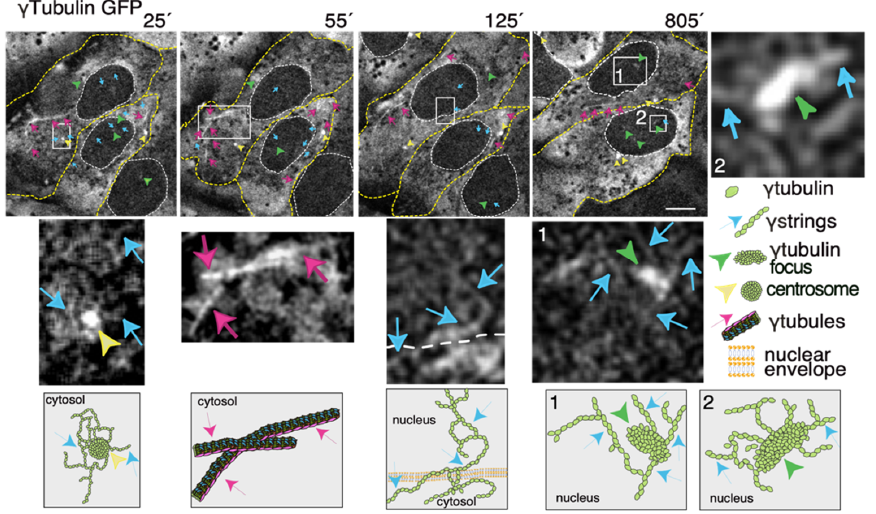
Figure 3. The dynamics of the γ -tubulin meshwork in living cells. Time-lapse series of fluorescence images showing U2OS cells stably coexpressing TUBG-short hairpin (sh)RNA and GFP-tagged sh-resistant γ -tubulin ( γ tubulin GFP). Images present chosen frames illustrating the changes in the position of γ -strings, γ -tubules, centrosomes, and γ -tubulin foci during the interphase. The outer membrane of the cells and the nuclei are indicated by dotted yellow and white lines, respectively. Yellow arrowheads, blue arrows, and magenta arrows indicate centrosomes, γ strings, and γ -tubules, respectively. Green arrowheads denote nucleating γ -tubulin foci. The images shown were collected every 5 min and represent selected frames showing the changes that γ strings, γ -tubules, centrosomes, and γ -tubulin foci undergo during interphase. White boxes indicate the areas magnified in the inset. Scale bars: 10 µ m. The lower panels are schematic representations of the structures shown in the corresponding white box. See Videos S1–S3. The stable cell line was obtained, and time-lapse experiments were performed as previously described [10,12,35]. These data are from unpublished works by Alvarado-Kristensson et